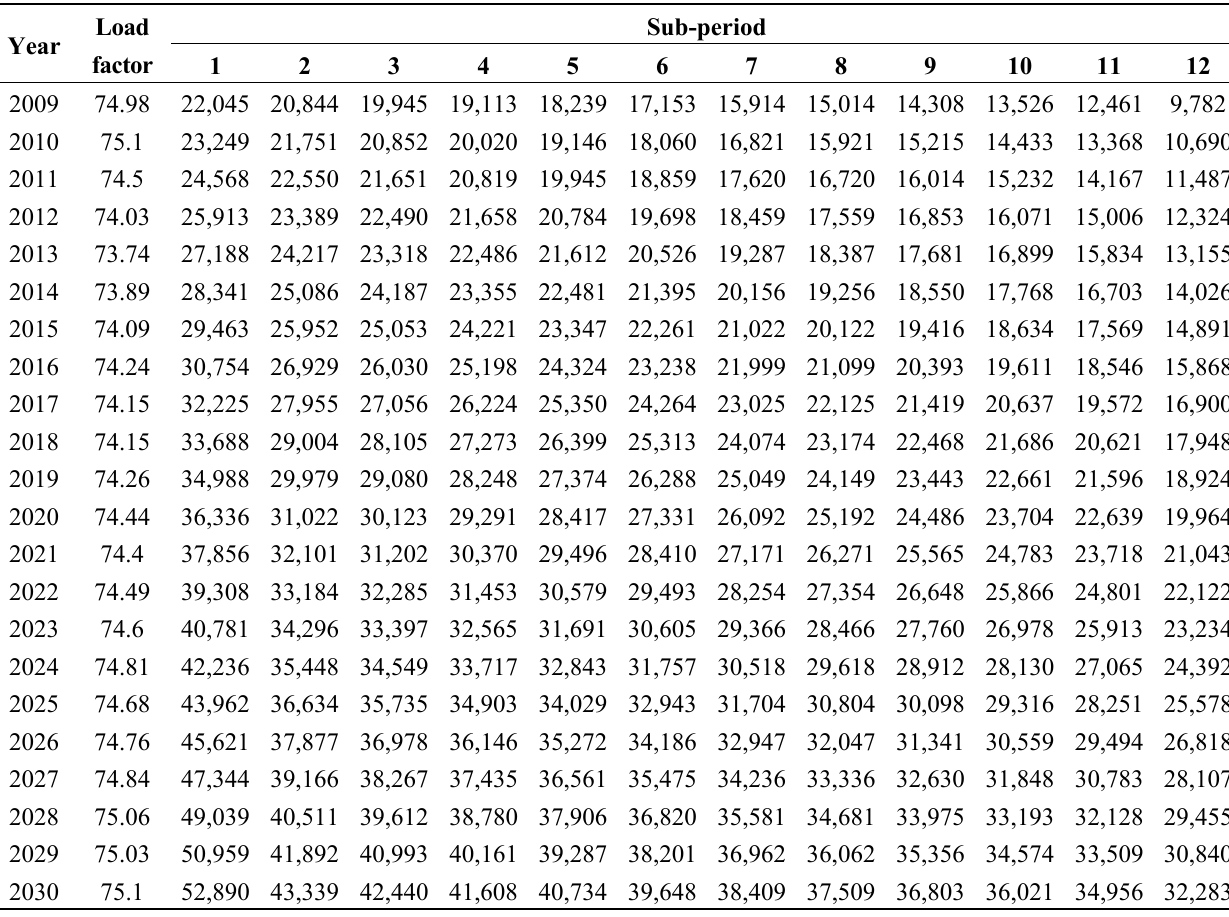
Table 1. Load profiles of in the PGEP model.